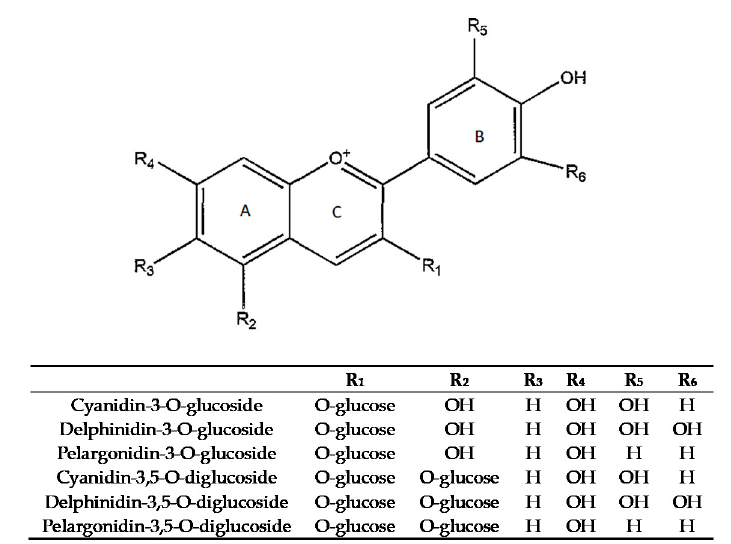
Figure 1. Anthocyanins in pomegranate juices [23].